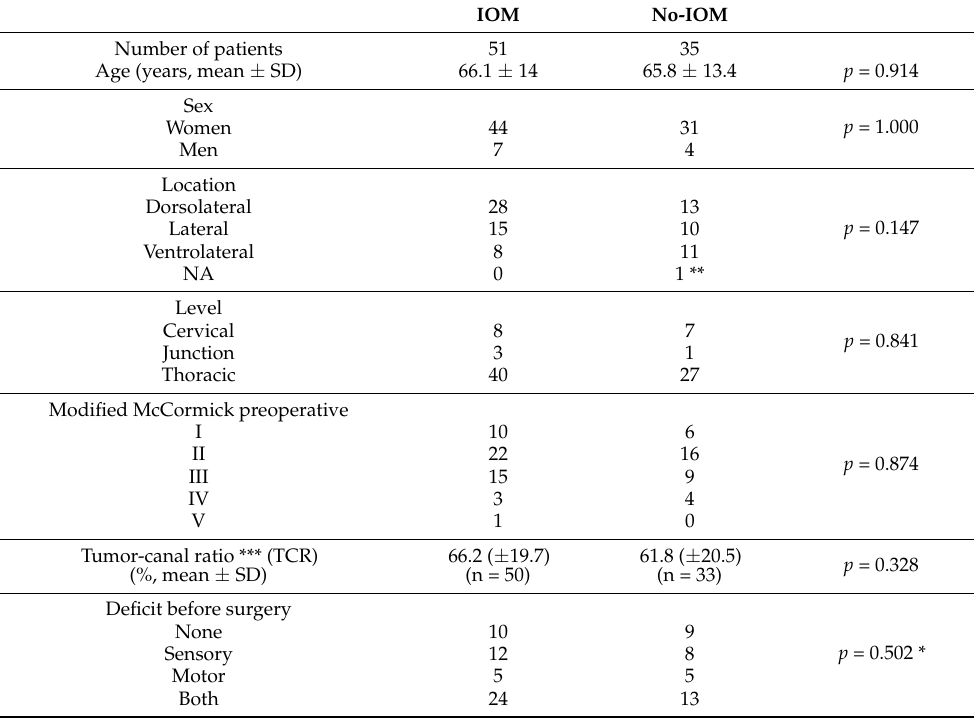
Table 4. IOM versus no-IOM, before surgery.